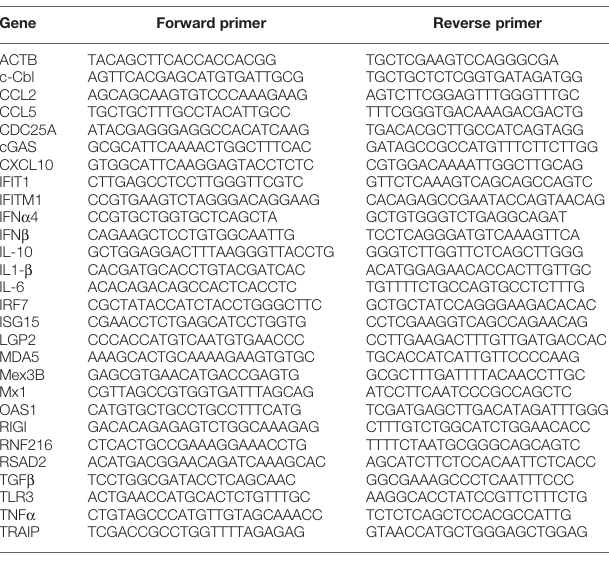
TABLE 1 | Primers used for